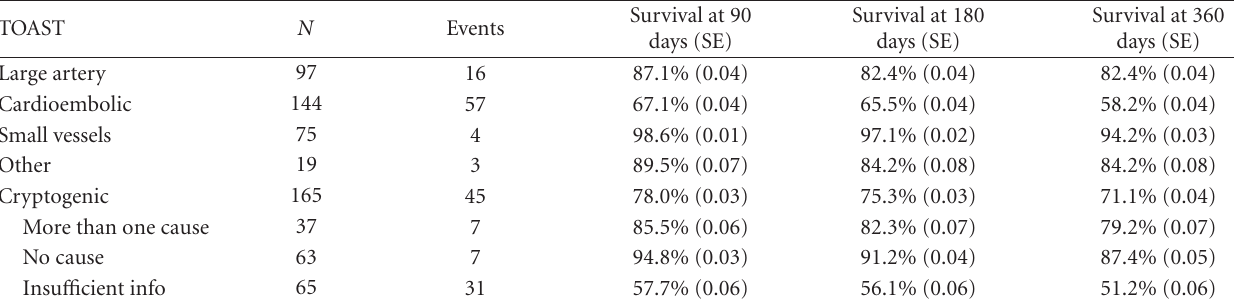
Table 2: Survival estimates within the first